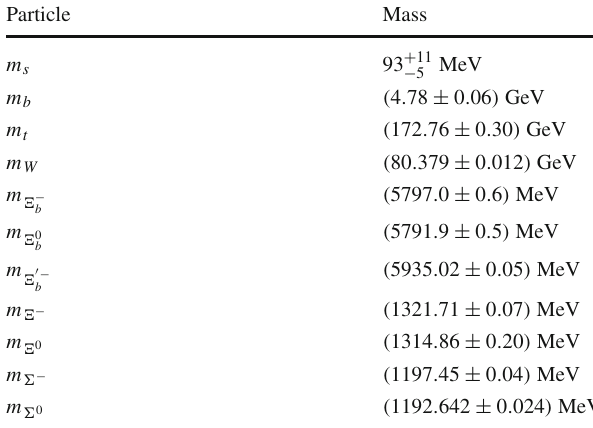
Table 1 The values of quark, W boson and baryon masses [42] Particle Mass